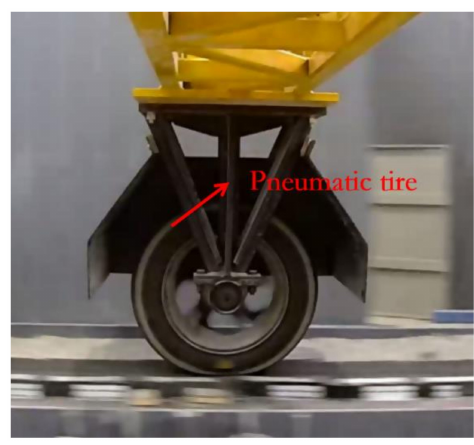
Figure 5. CVS working scene.